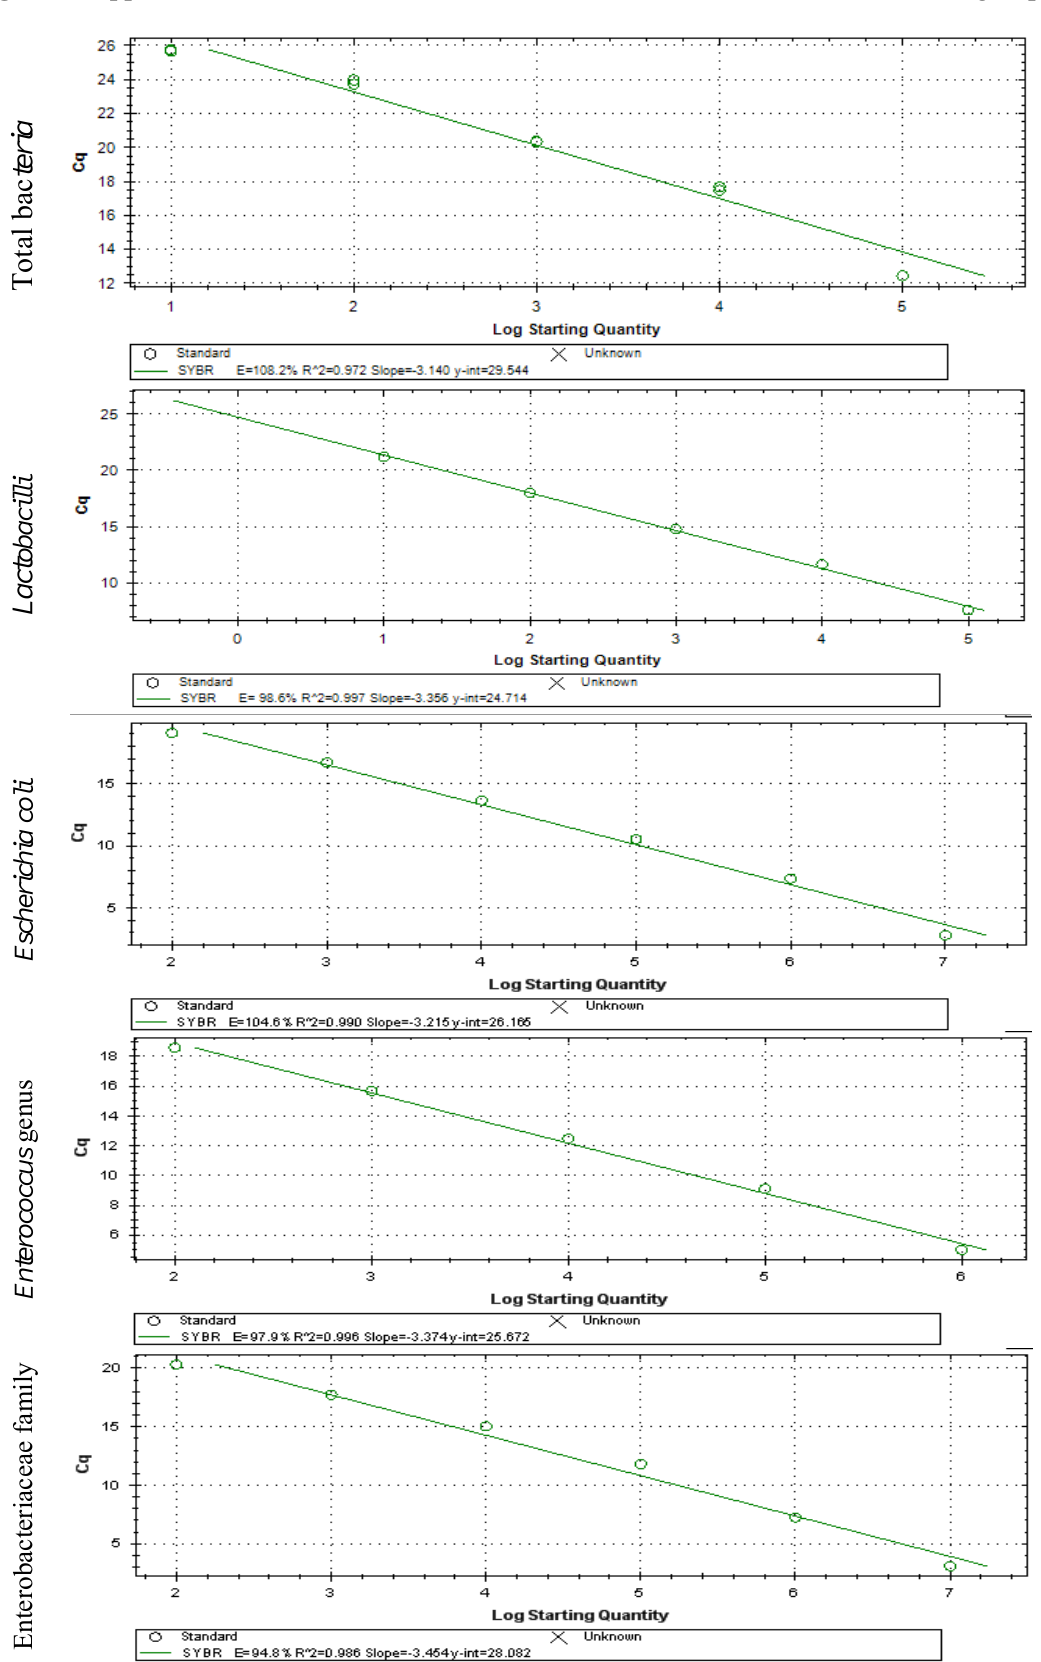
Figure 1. Application curve for serial 10-fold diluted DNA curve of different bacterial